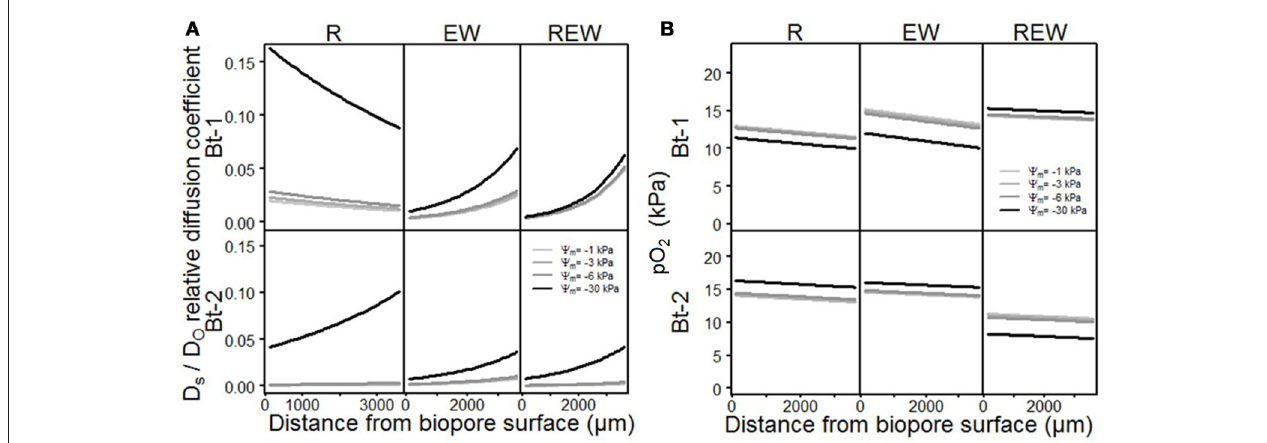
FIGURE 6 | Model output of the statistical analysis for (A) relative diffusion coefficient D s /D O ratio of soil oxygen diffusion coefficient (D S ) to air (D O ) and (B) oxygen partial pressure pO 2 , of biopore walls [pore colonized by root (R), colonized by L. terrestris (EW) and (REW) just as R but followed by short-term ( < 6 months) colonization of L. terrestris ] as a function of matric